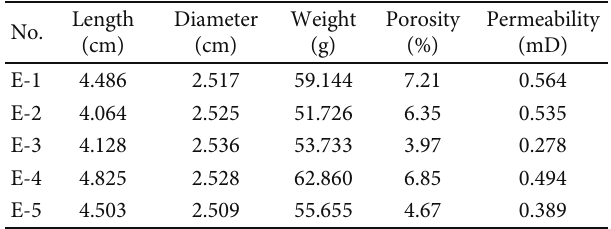
Table 2: Basic parameters of the experimental core.